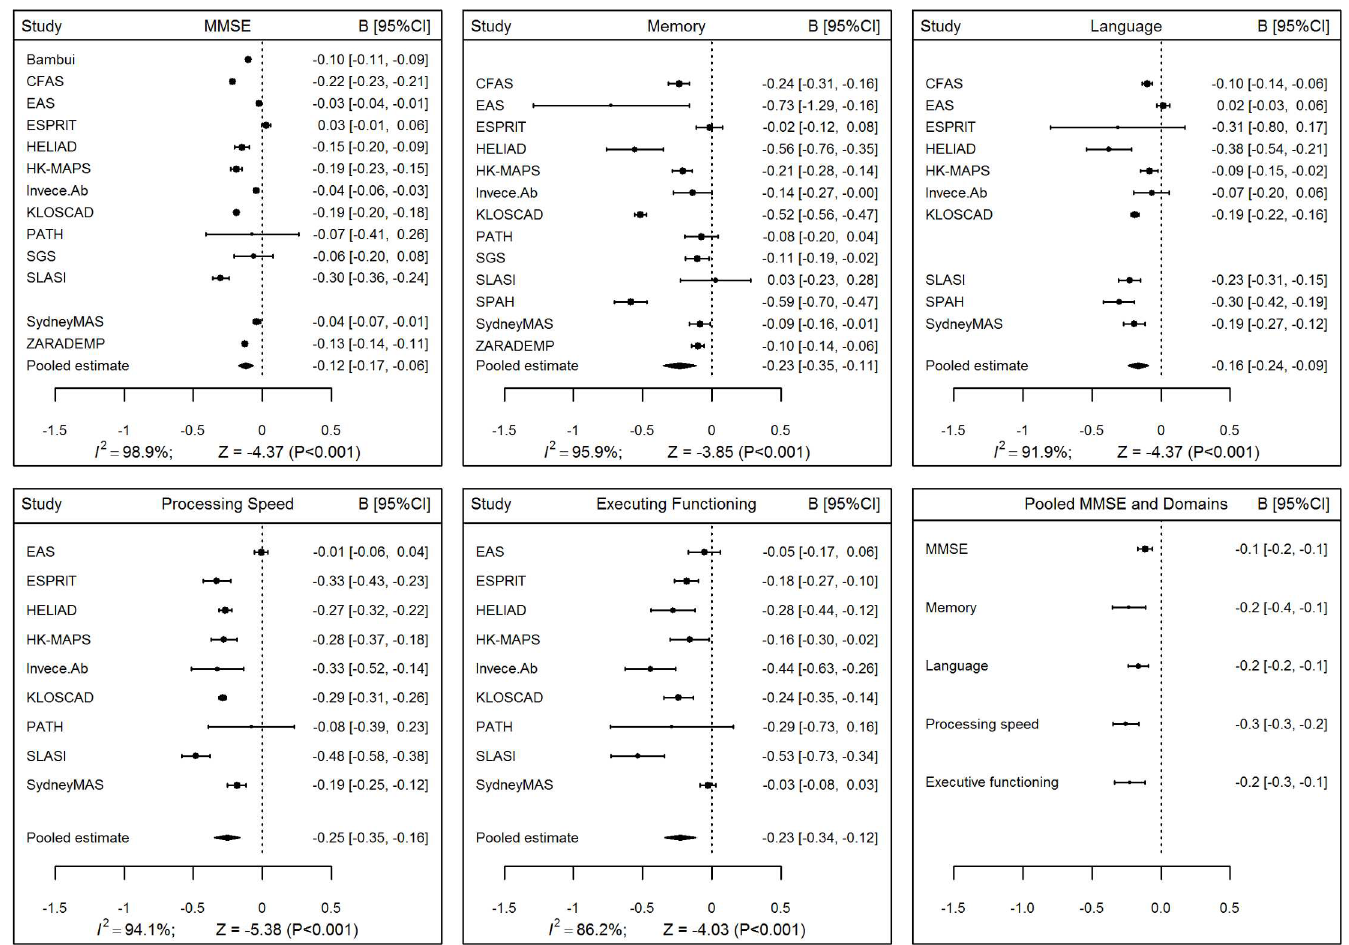
Fig 1. Forest plots for associations between age and Mini-Mental State Examination (MMSE) and cognitive domain scores. The x -axis plots changein Z-score units per decade; negativevalues indicate declinewith age.